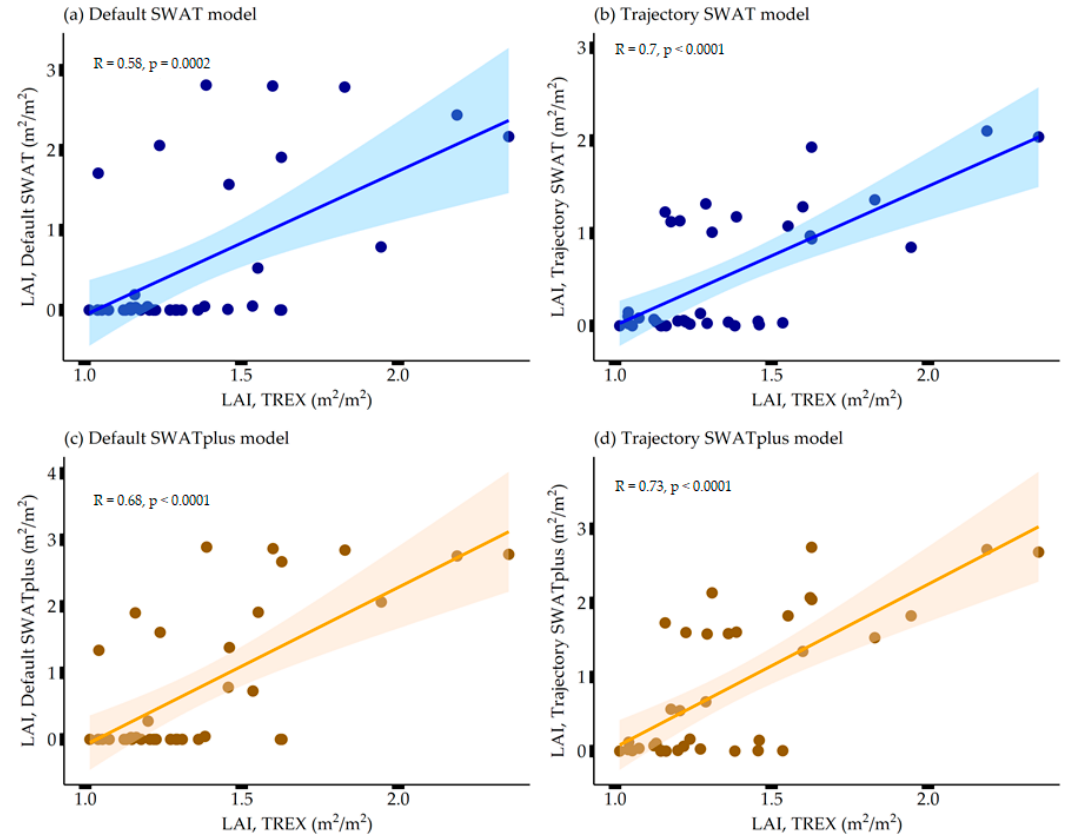
Figure 6. Correlation analysis between TREX LAI and SWAT and SWAT+ default models and rainfed maize to irrigated mixed crops to irrigated mixed crops trajectory outputs.